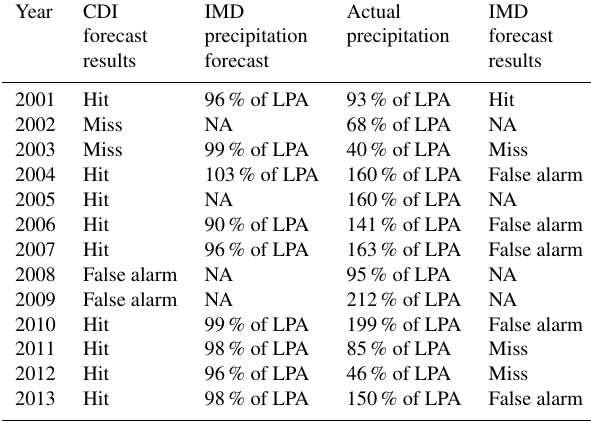
Table 3. A comparison of the CDI forecasts and the JJAS total sea- sonal precipitation forecasts generated by the India Meteorological Department (IMD). Column 2 is a repeat of column 4 in Table 2; a record of the accuracy of CDI forecasts is expressed in terms of hits and misses. Column 3 contains the forecasts issued by IMD, and column 4 is the actual observations of JJAS seasonal total rainfall using rainfall data from the Satara district itself. The fifth and final column of Table 3 shows the accuracy of the IMD forecasts in terms of hits and misses using their own 5-category system.